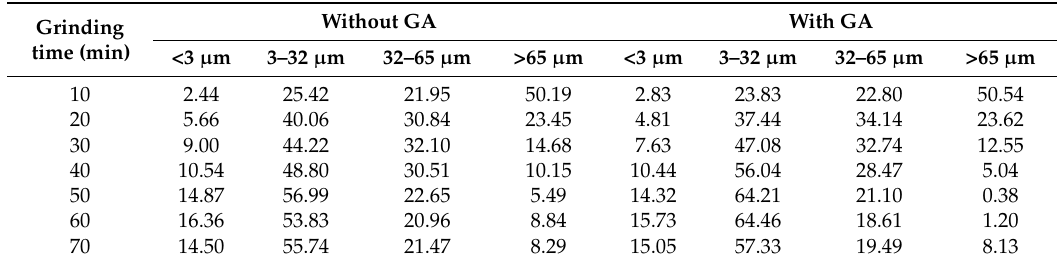
Table 6. Particle size distribution of steel slag powder with GA under different grinding time (%).